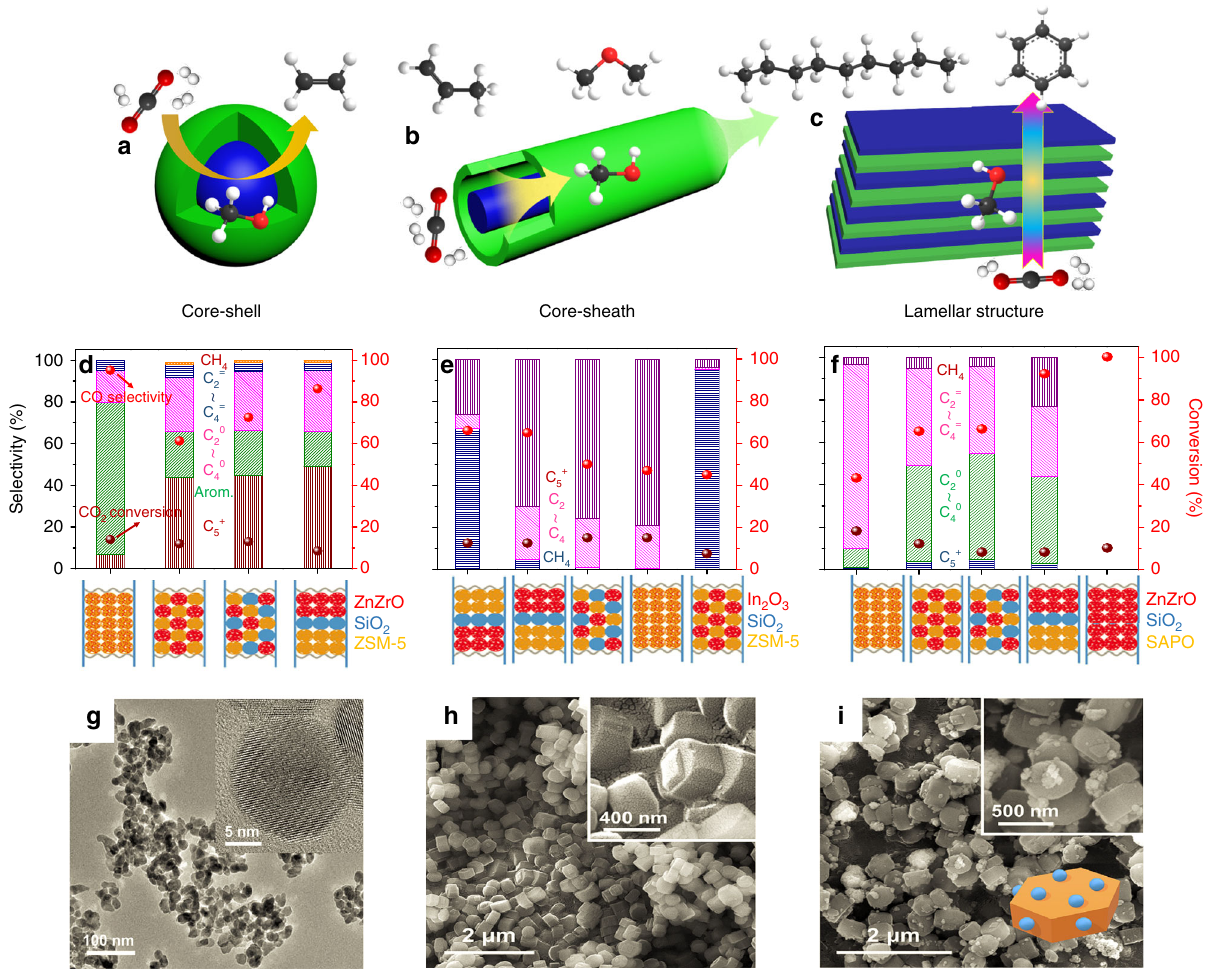
Fig. 4 The structure and performance of bifunctional catalysts. a – c Proposed structures of bifunctional catalysts. d – f Hydrogenation of CO 2 over bifunctional catalysts, which are integrated methanol synthesis catalyst and zeolites, with different spatial arrangements. (Adapted with permission from Li et al. 71 . Copyright (2019) Elsevier); Gao et al. 26 . Copyright (2017) Springer Nature; Li et al. 16 . Copyright (2017) American Chemical Society). g – i TEM